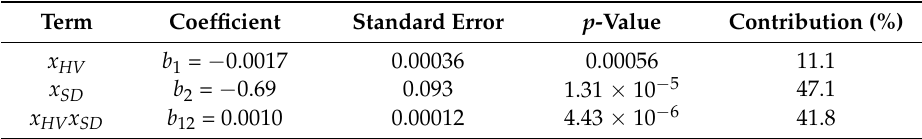
Table 8. The regression coefficients, standard errors, p -values, and contributions for the model of case depth with the ground sample data set. The intercept term is b 0 = 1.55.